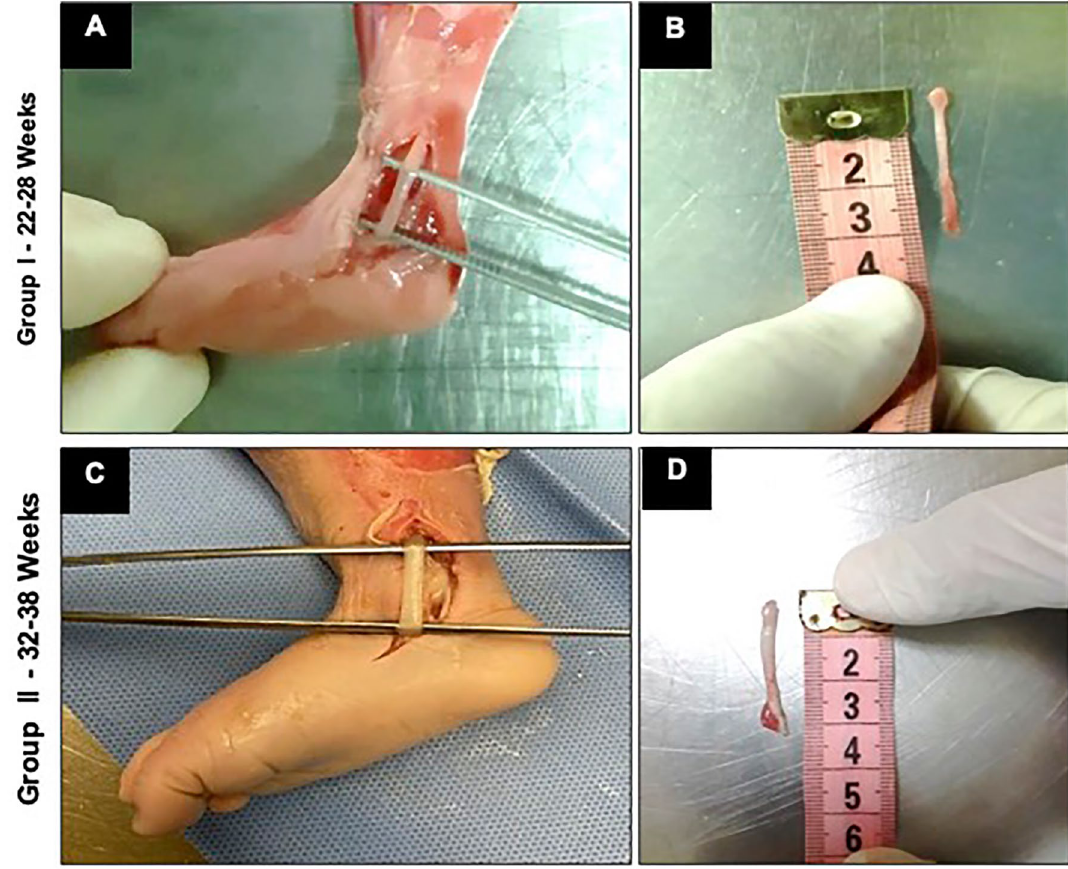
Figure 1. Dissection of tendon specimens. ( A , B ) Fetuses of Group I from 22 to 28 weeks; ( C , D ) Fetuses of Group II from 32 to 38 weeks. ( A , C ) Dissection of the fetus ankle of the tibialis posterior tendon from its origin to its insertion. ( B , D ) Measurement of the sample obtained from one of the lower limbs of a